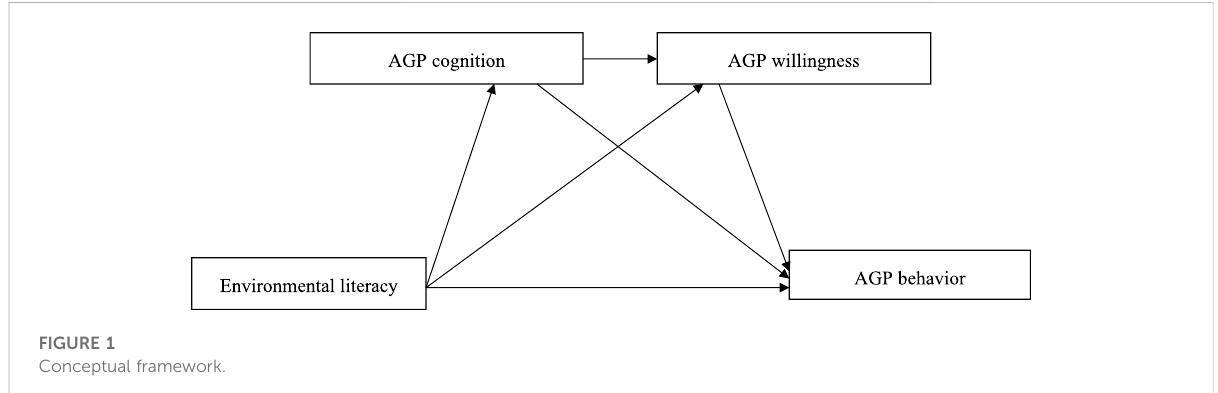
FIGURE 1 Conceptual framework.